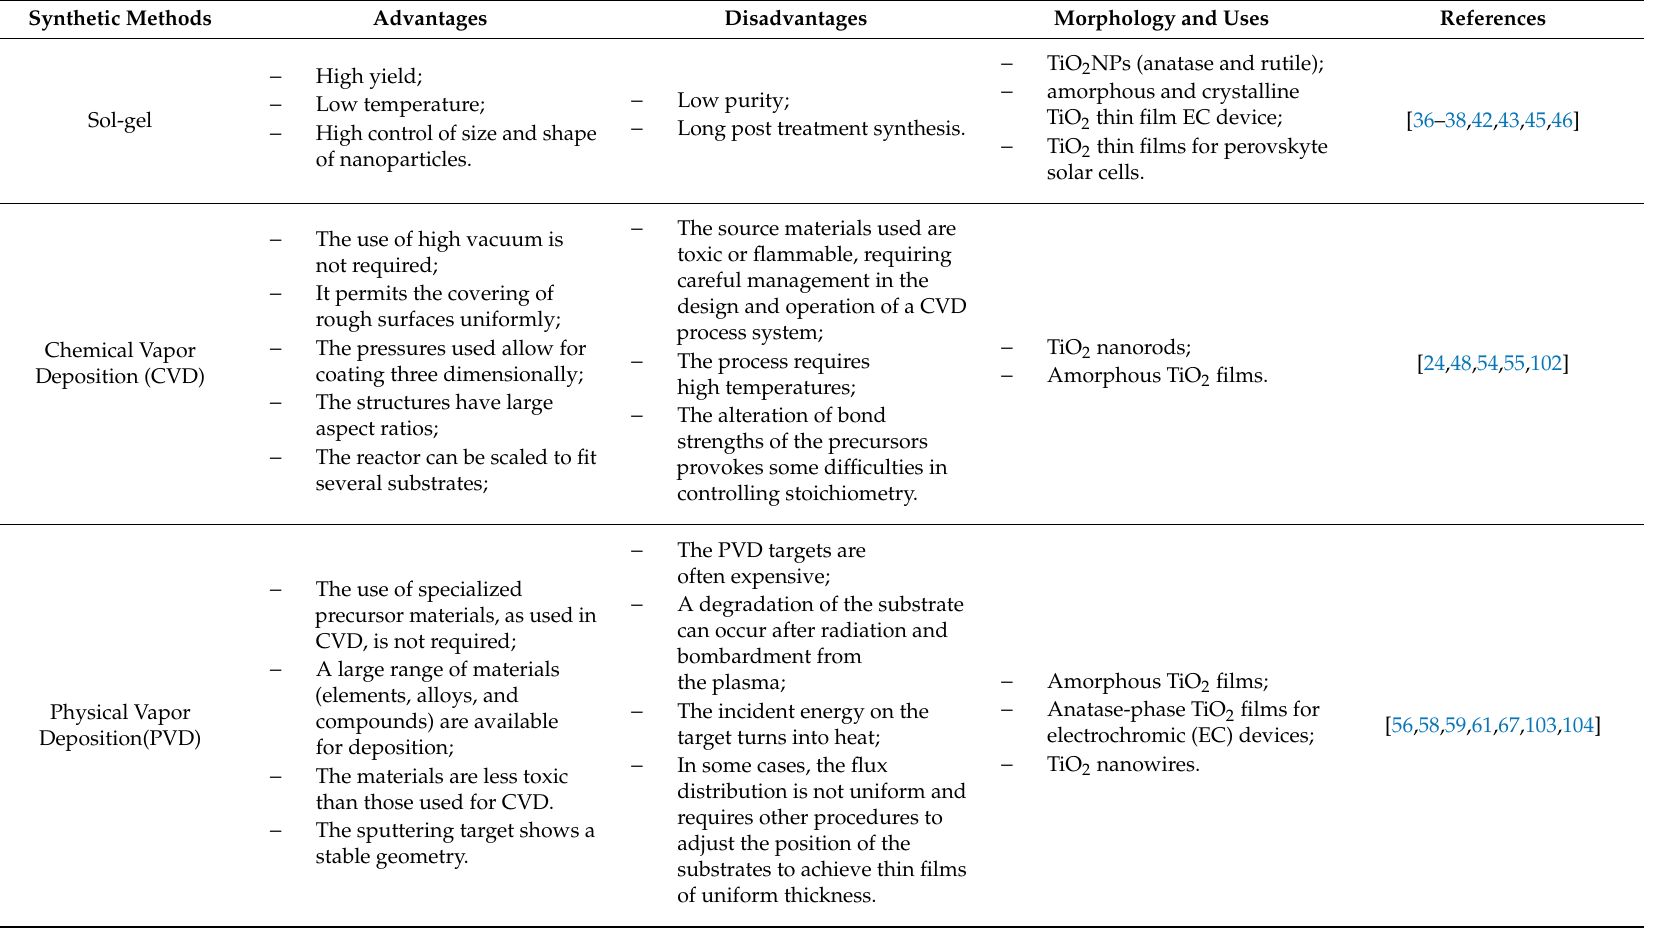
Table 1. Synthetic routes, advantages, disadvantages, and morphology of nanoTiO 2